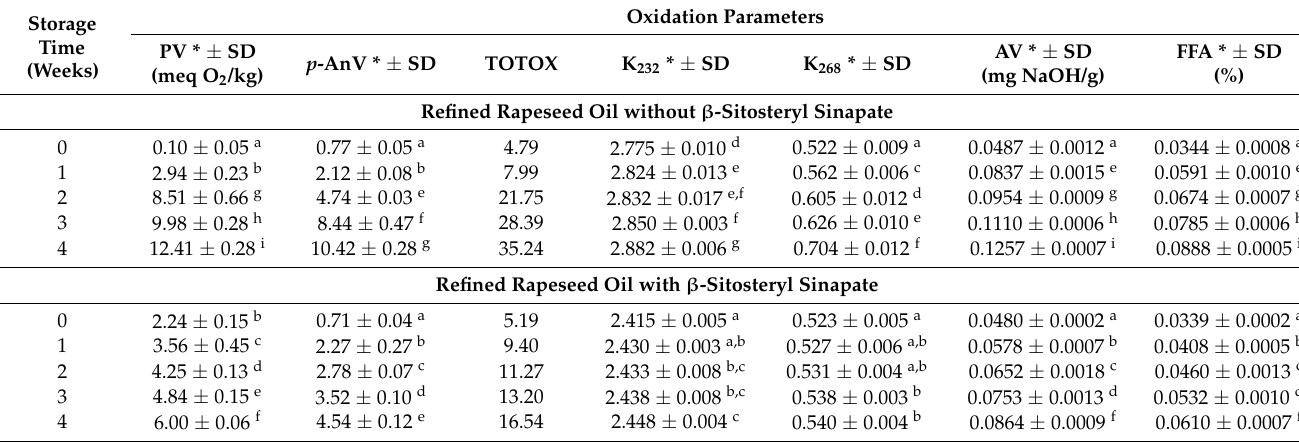
Table 1. Oxidation parameters of rapeseed oils without ant with β -sitosteryl sinapate stored under accelerated conditions. Storage Time